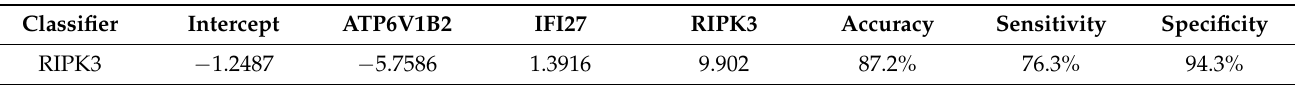
Table 2. First dataset: Characteristics of RIPK3 together with ATP6V1B2 and